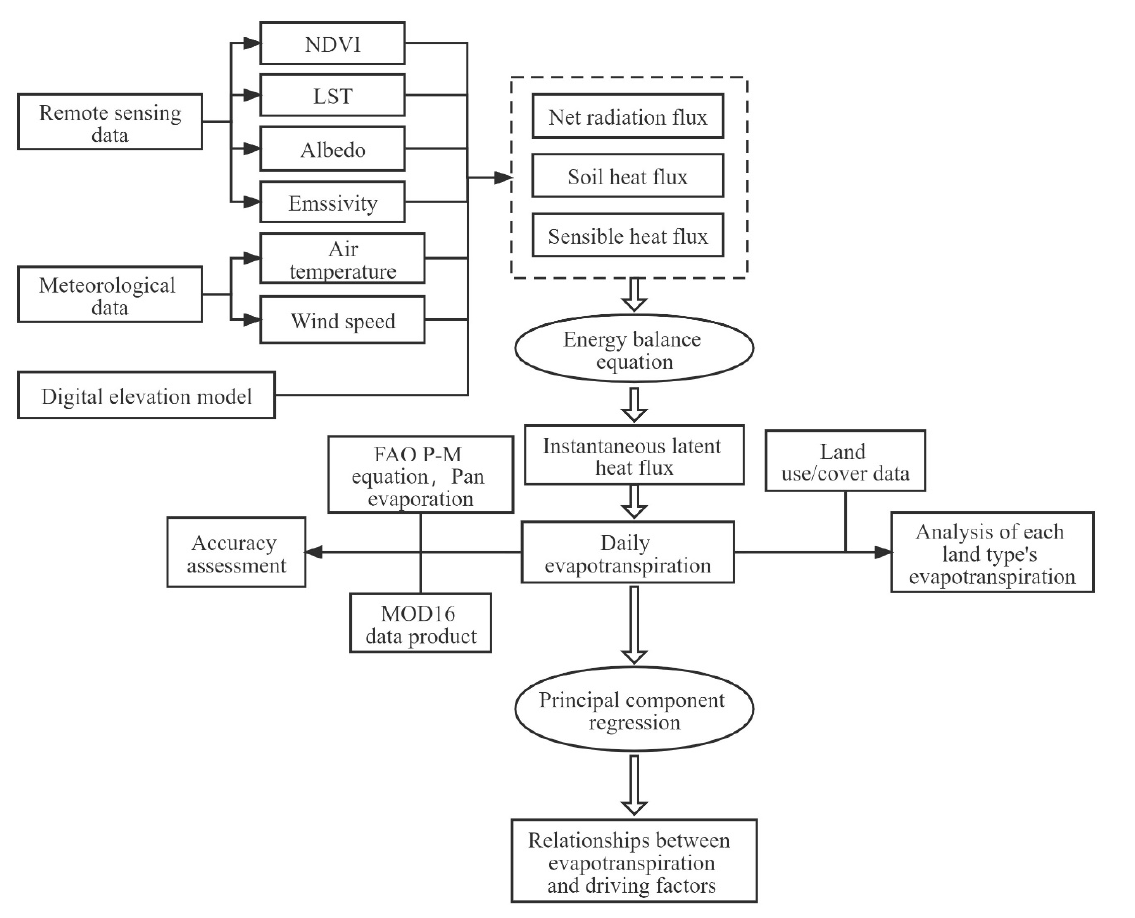
Figure 2. Overall framework diagram.